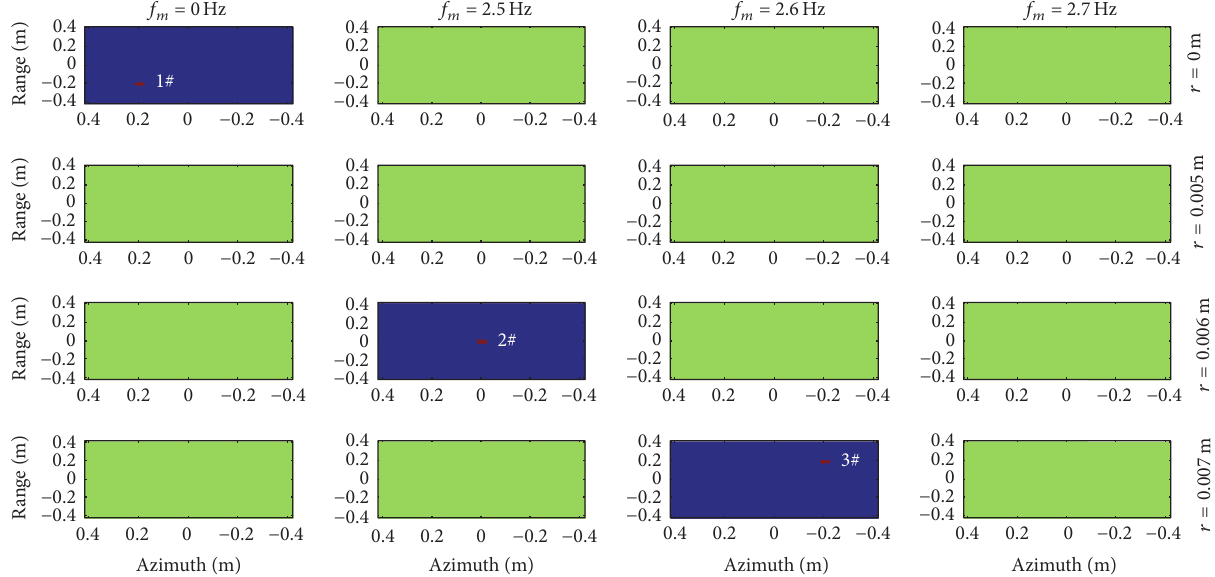
Figure 7: THz-SAR image of point targets in Table 2 under − 10dB SNR, refocused via ExCoV